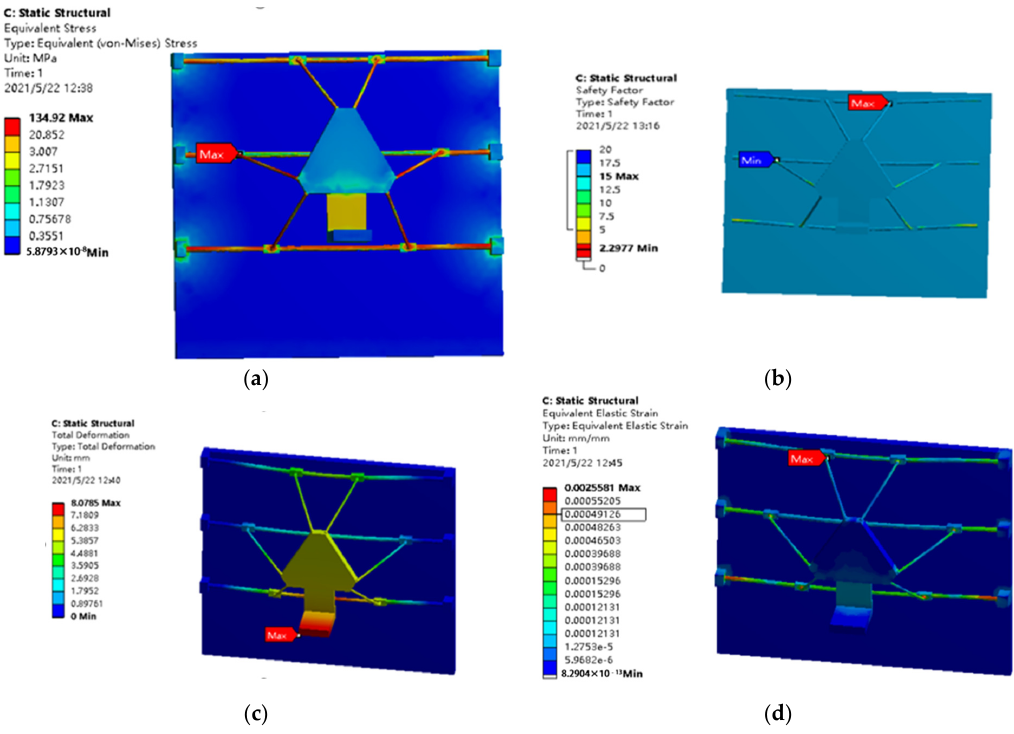
Figure 12. Structural static simulation results: ( a ) equivalent force nephogram; ( b ) safety factor nephogram; ( c ) total deformation nephogram; ( d ) strain